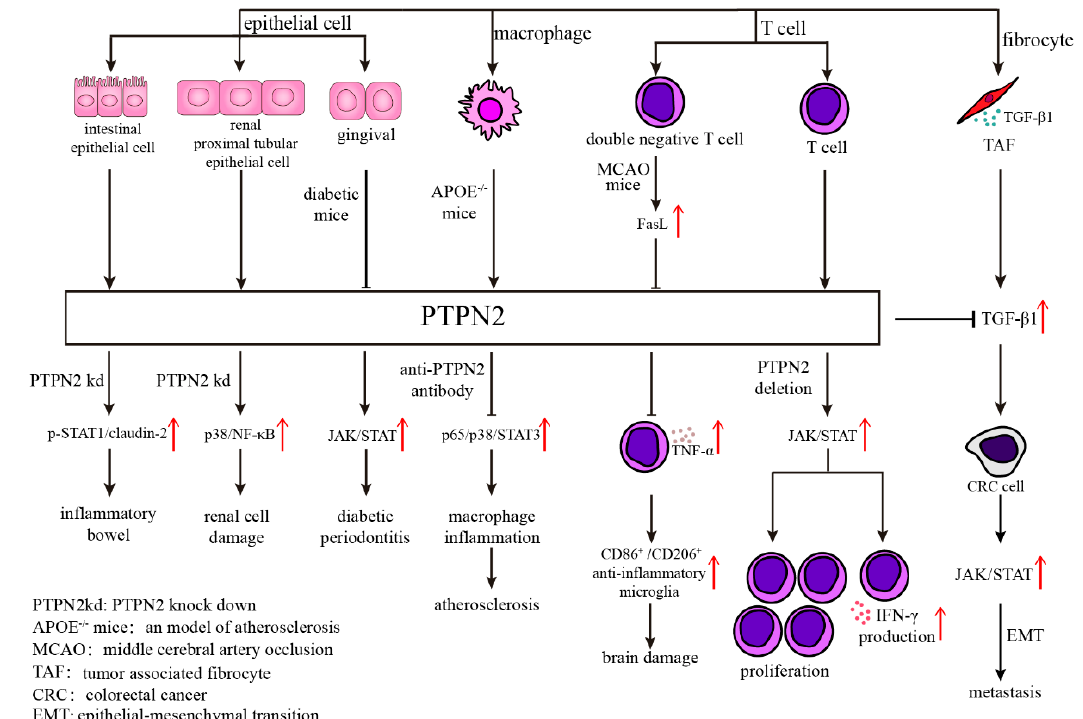
Figure 2. Various mechanisms of PTPN2 in different kinds of cells. Abnormal expression of PTPN2 in epithelial cells will result in many diseases through different mechanisms, such as p-STAT1/claudin-2 in inflammatory bowel, p38/NF- κ B in renal cell damage, and JAK/STAT in diabetic periodontitis. The antibody of PTPN2 in APOE − / − mice inhibits atherosclerosis through diminishing p65/p38/STAT3 signaling pathway. What’s more, PTPN2 influences T cell function, including cell proliferation and IFN- γ production, through JAK/STAT signaling pathway.